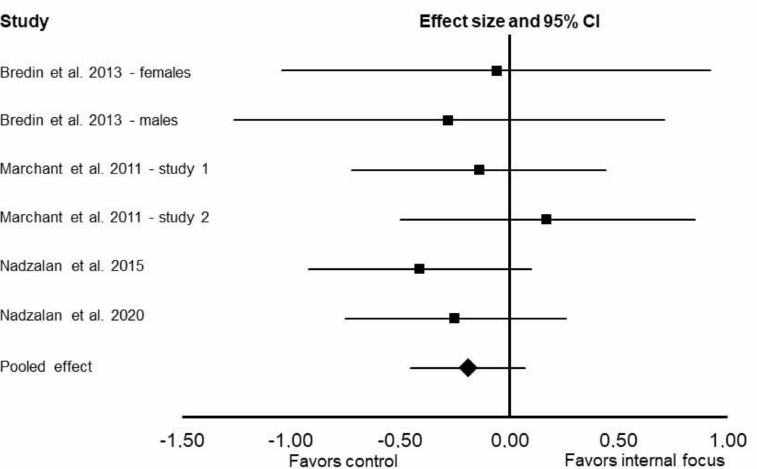
Figure 4. Results of the random-effects meta-analysis comparing the effects of internal focus vs. control on muscular endurance. Data are reported as effect sizes (Cohen’s d ) and 95% confidence interval (CI). The diamond at the bottom presents the overall effect. The plotted squares denote effect sizes, and the whiskers denote their 95%